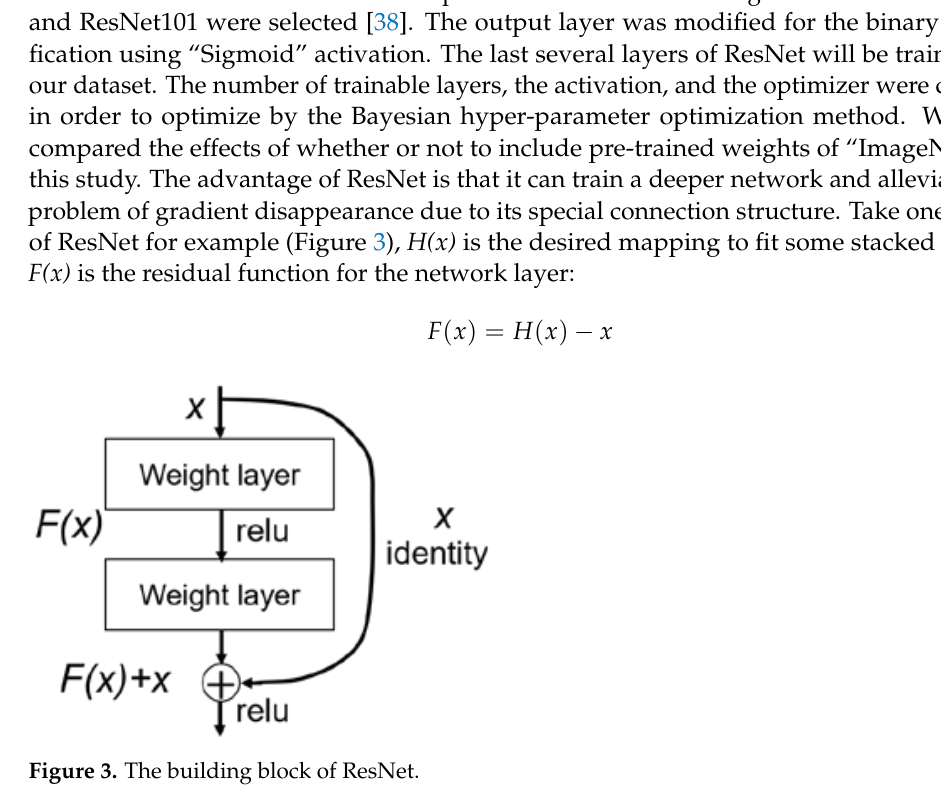
Figure 2. The schematic figure of the model.